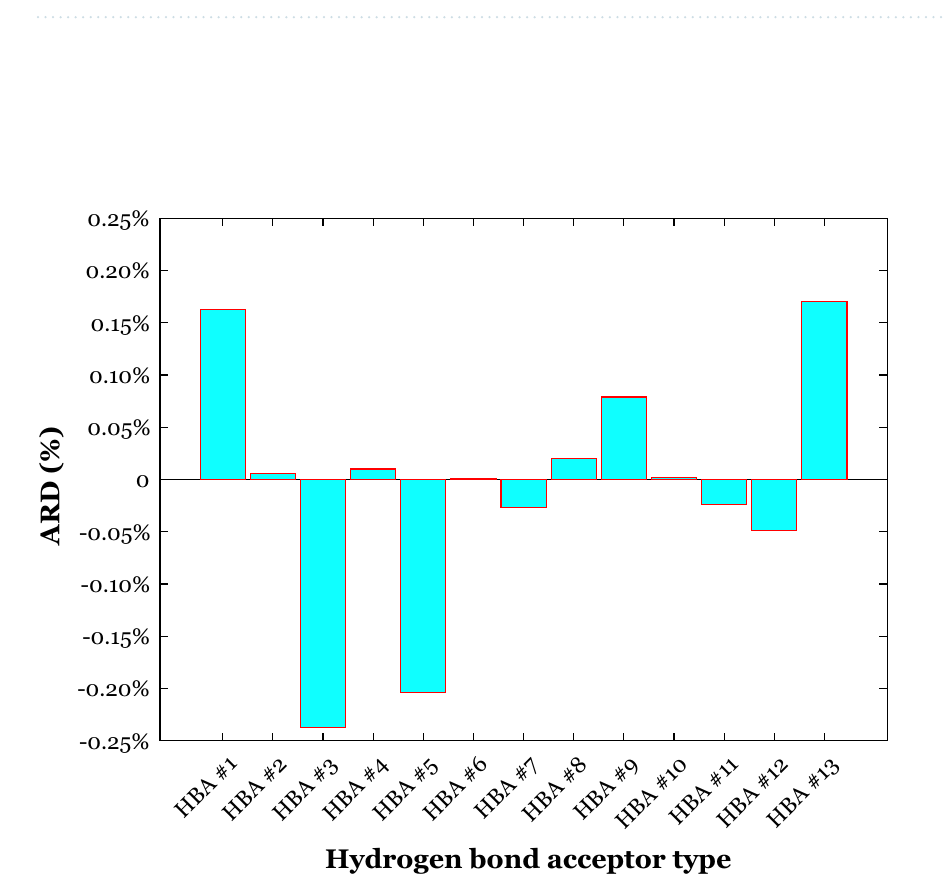
Figure 7. The observed average relative deviation between actual and predicted densities of the deep eutectic solvent with the same HBA